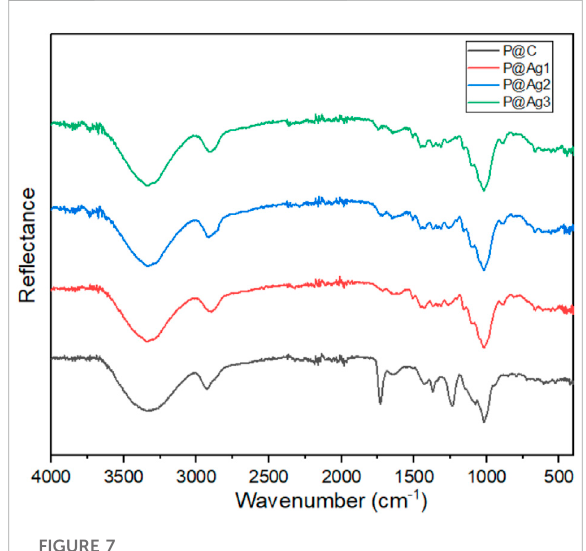
FIGURE 7 FTIR analysis of control and AgNP coated kraft